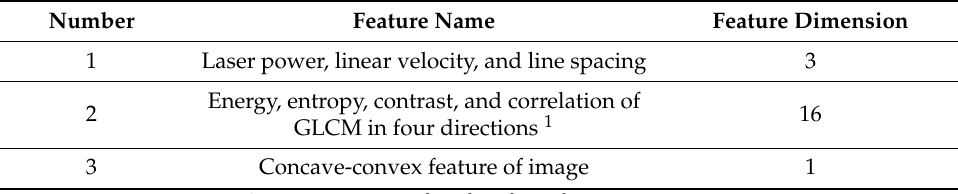
Table 1. Training data list of support vector machine